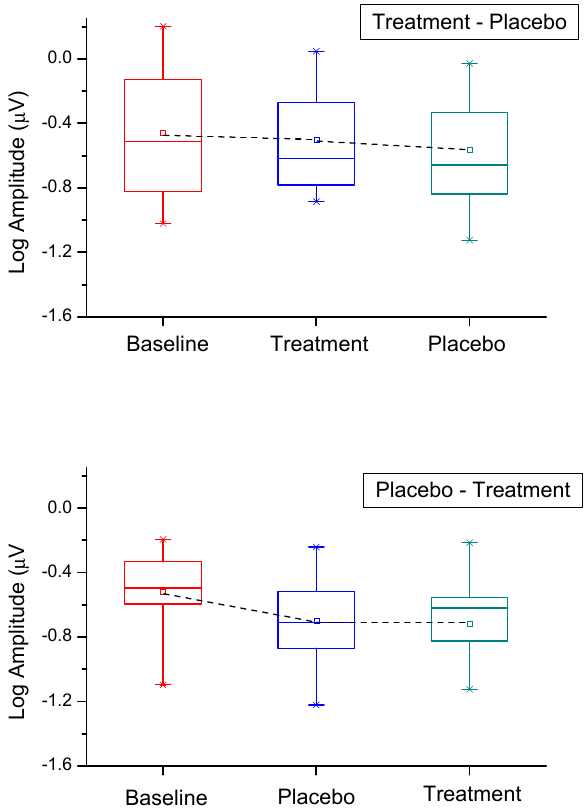
Figure 1. Box plots the fERG amplitude values recorded at baseline and after six months of S (Treatment) or P (Placebo) supplementation, following the cross-over study design. The symbol and line in the middle of the box indicate the mean and the median, the box lower and upper boundaries the 25th and 75th percentiles, and the lower and upper whiskers the 5th and 95th percentiles, respectively.